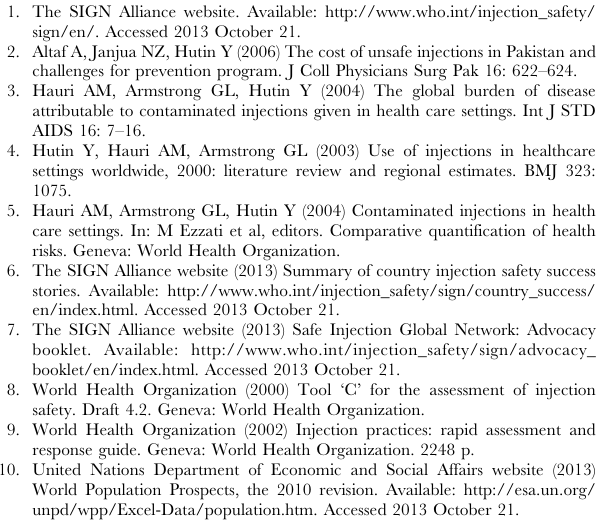
Table S1 Countries with data used for the 2000 measurements. Table S2 Countries with data from Demographic and Health Surveys (DHS) used for the 2010 measurements. Table S3 Countries where the proportion of re-use (‘p r ’) was measured within a three-year interval through both a Demo- graphic and Health Survey 11 and an injection safety survey. Table S4 Countries where two Demographic Health Surveys (DHS) were performed which included injection data. Table S5 Countries where two injection safety surveys were performed which measured the proportion of re-use (‘p r